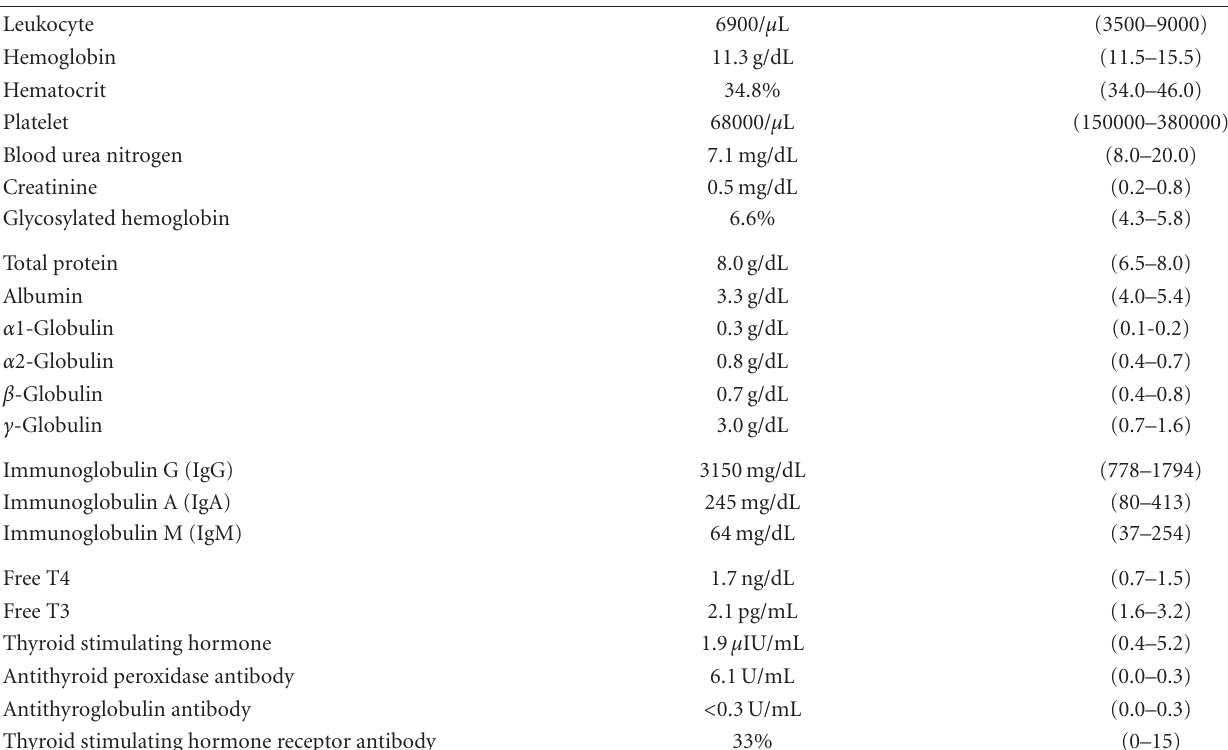
Table 1: Laboratory data of the patient.